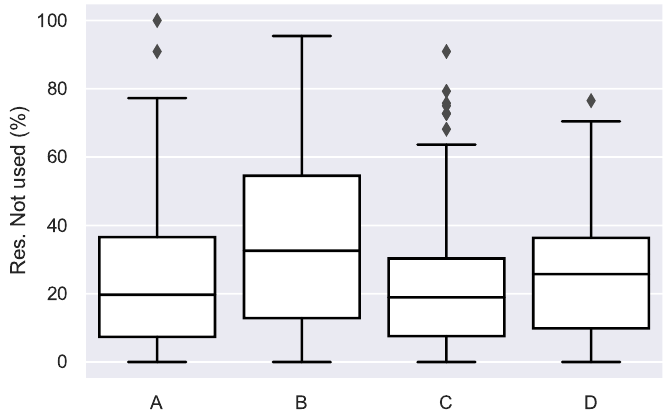
Figure 8. Percentages of time in which a room is reserved but not